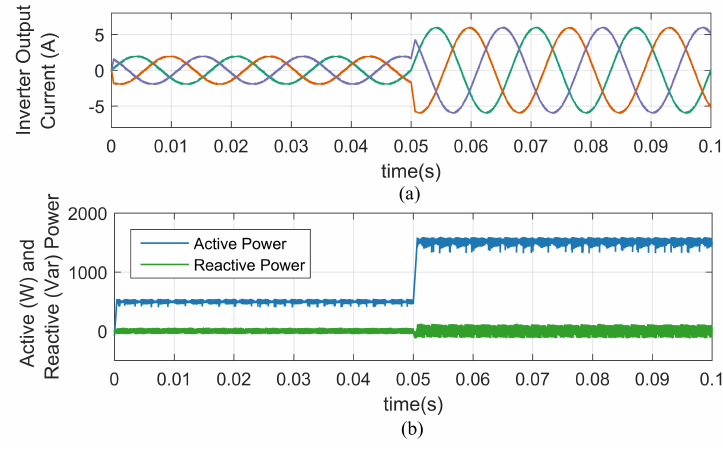
Figure 10. Simulation results with hysteresis controller. ( a ) Three-phase output current of inverter. ( b ) Active and reactive power